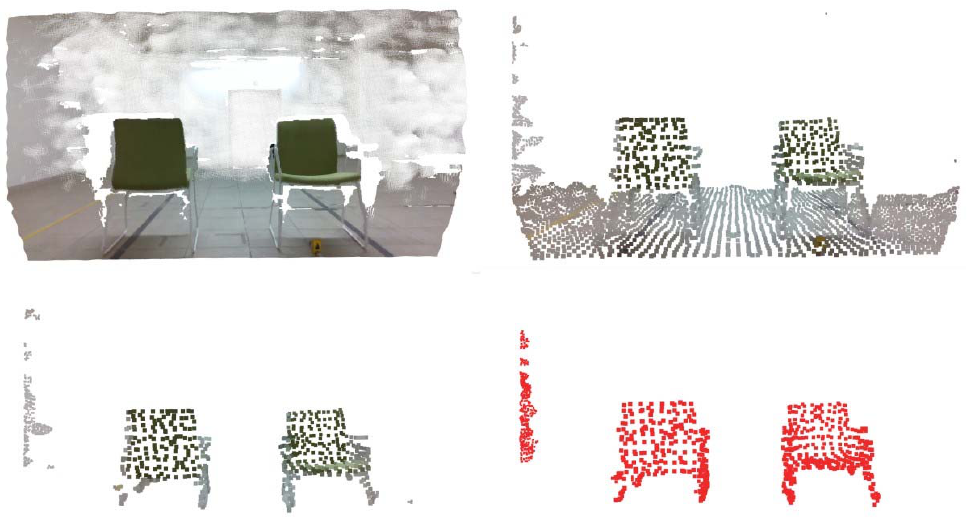
Figure 3. Indoor results for the four stages of processing. From top-left to bottom-right: original point cloud, down-sampled and range-limited point cloud, point cloud after ground plane removal and point cloud with detected clusters (two chairs).